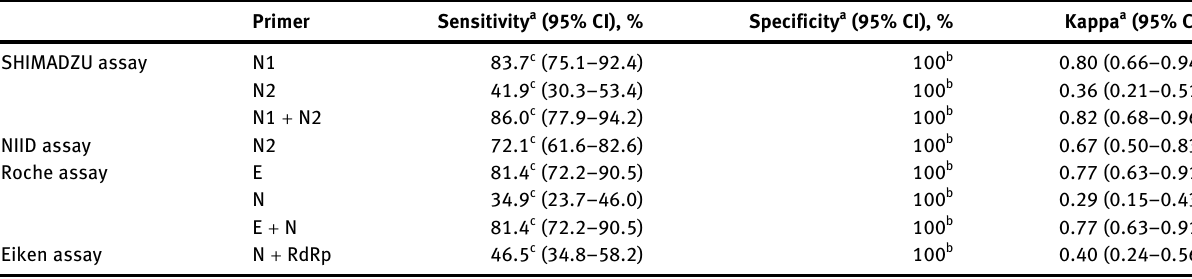
a Calculatedagainstthede fi nedreferencestandard. b  %CIcouldnotbecalculated. c p<  .  ,comparedwiththede fi nedreferencestandard.CI, con fi dence interval; NIID, National Institute of Infectious Diseases; RdRp, RNA-dependent RNA polymerase; Overall diagnostic performance of four SARS-CoV-  detection assays was evaluated with  samples because the SHIMADZU assay could not test one sample due to sample shortage.